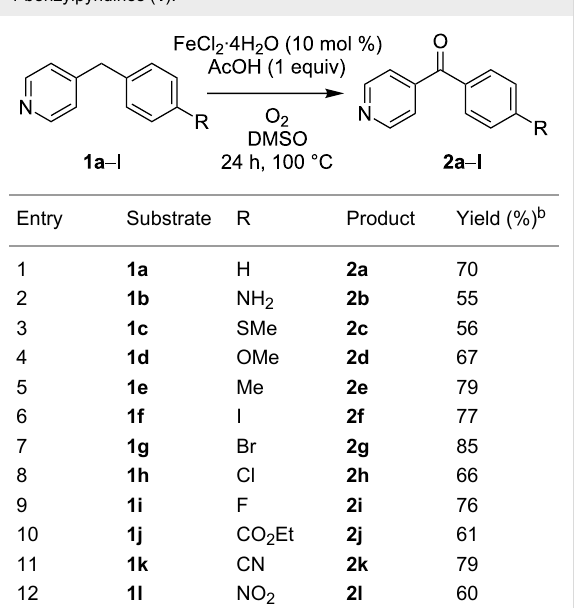
Table 1: Iron-catalyzed aerobic oxidation of phenyl-substituted 4-benzylpyridines ( 1 ).